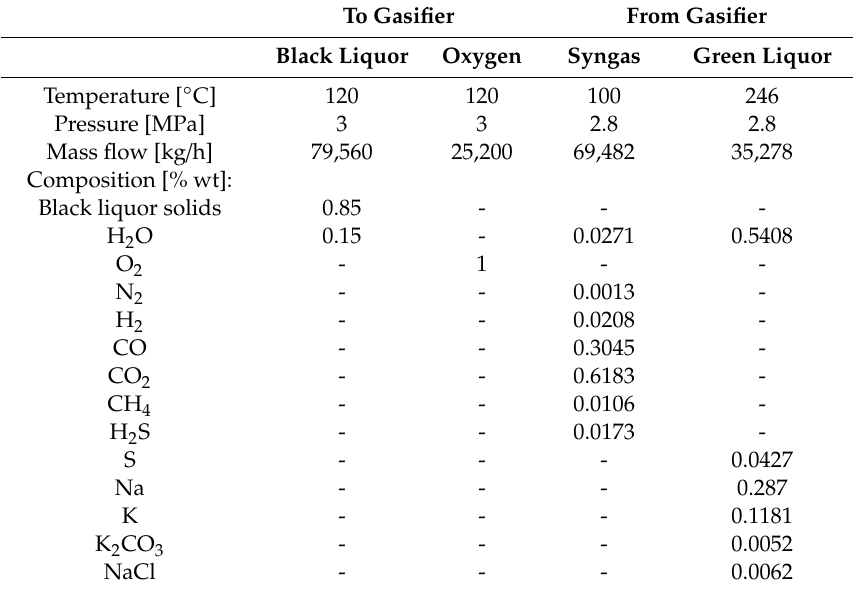
Table A1. Detailed gasifier operation simulation